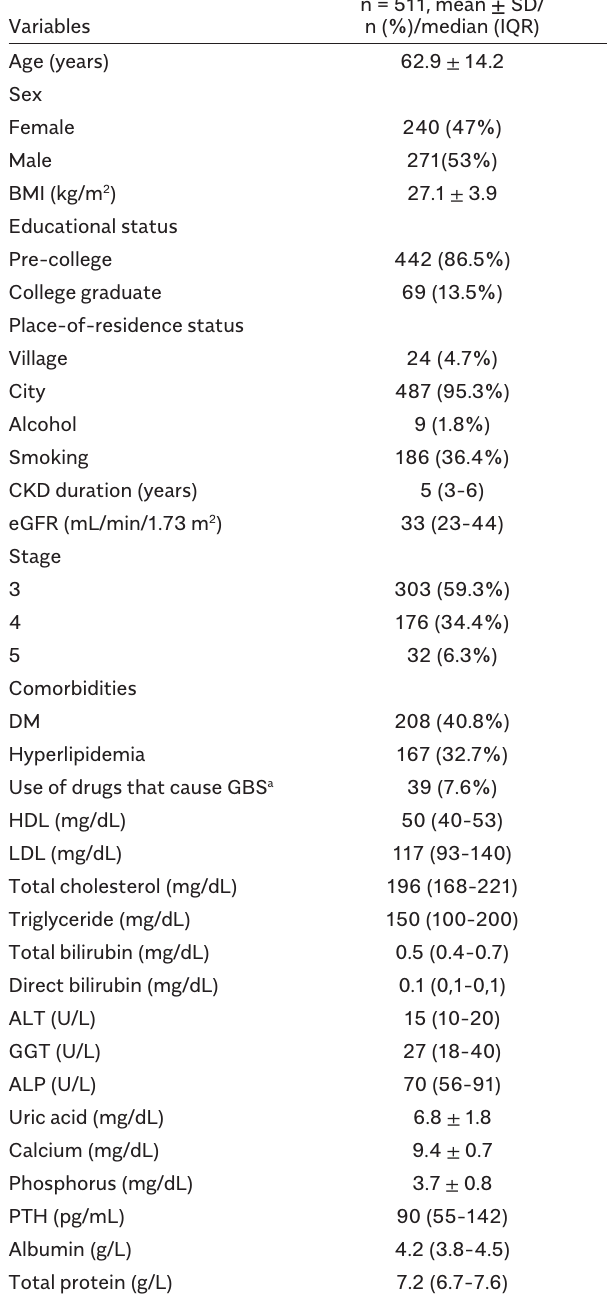
Table 1. Demographic and Clinical Characteristics and Laboratory Parameters of the Patients with Chronic Kidney Disease